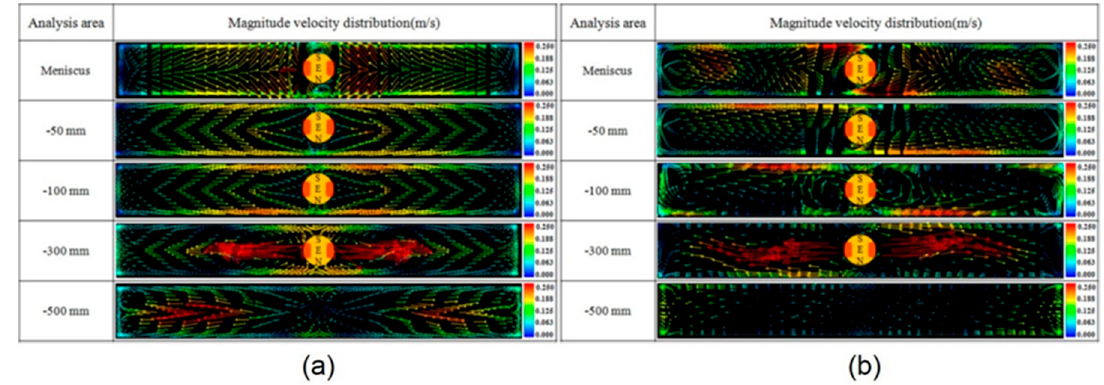
Figure 12. Flow patterns at various horizontal sections of the mold with ( a ) no magnetic field and ( b ) combined moving and static magnetic fields [55]. ( b ) combined moving and static magnetic fields